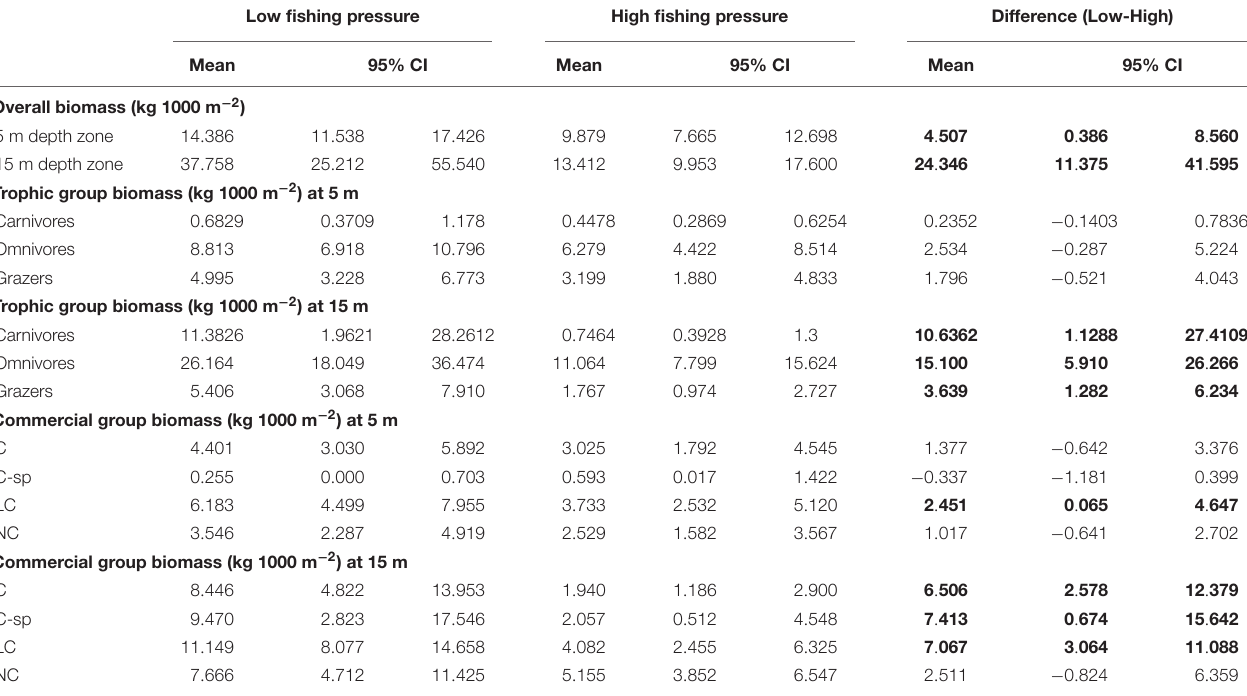
TABLE 4 | Mean biomass values (kg 1000 m − 2 ) and with the 95% confidence intervals (CI), of fish species for low and high fishing pressure sites of the Aegean Sea and for the difference between them (Low-High). Low fishing pressure High fishing